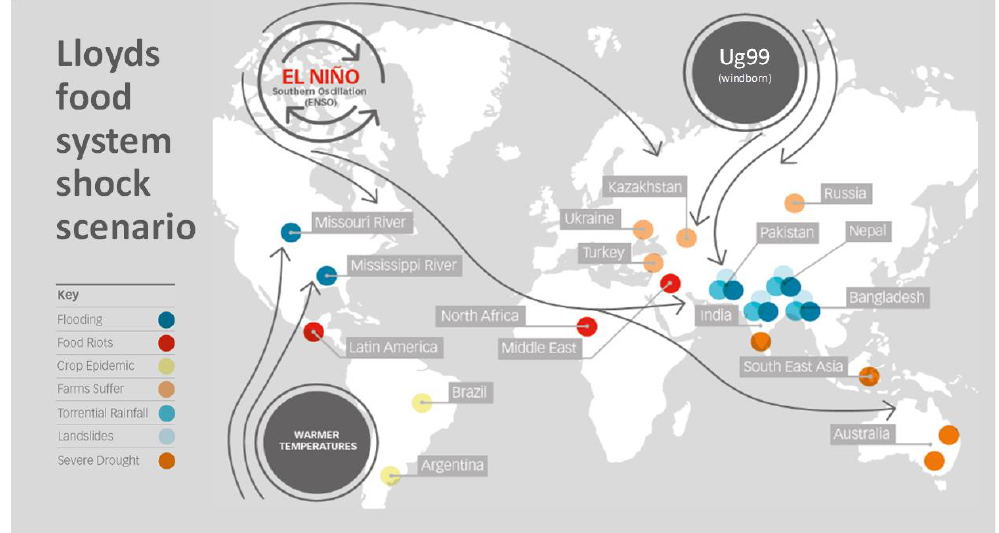
Figure 9 . Plausible scenario of a food systems shock. The Lloyd’s report aids crop modellers by clarifying the likely impacts of a plausible sudden food supply shock due to simultaneous occurrence of both biotic and abiotic stress on supply chains and societies [363]. Adapted from Lloyd’s report with the permission from the authors.